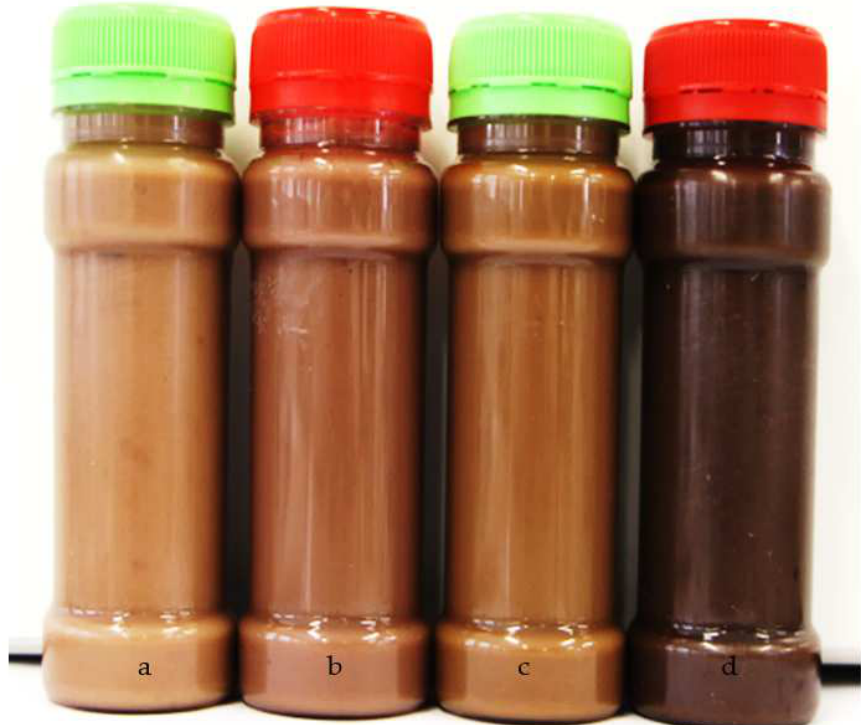
Figure 2. Bambara groundnut speciality malt syrups: ( a ) base malt syrup, ( b ) caramel malt syrup, ( c ) roasted malt syrup, ( d ) toasted malt syrup.